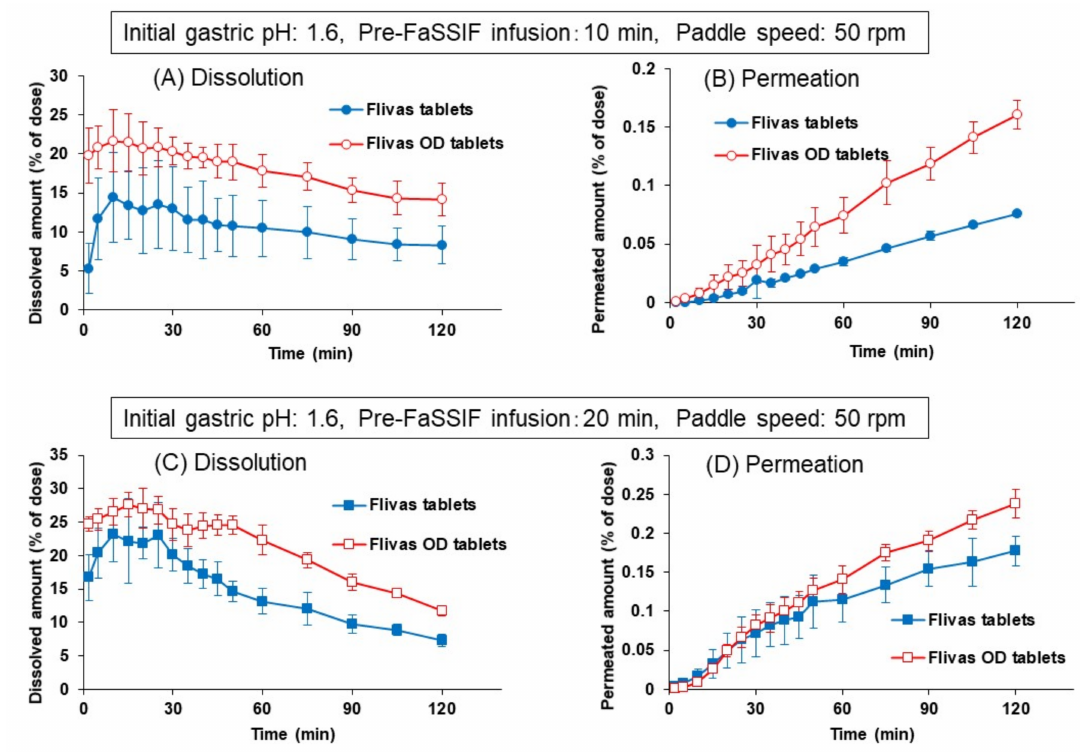
Figure 11. Effects of paddle speed (50 rpm) on the dissolution ( A , C ) and permeation ( B , D ) of naftopidil from Flivas ® tablets and Flivas ® OD tablets in the BE checker. Experiments were performed with a new experimental protocol with 1-min disintegration time. Pre-FaSSIF infusion time was set to 10 min ( A , B ) or to 20 min ( C , D ). Initial FaSSGF pH was 1.6. Each data point represents mean ± S.D. ( n =